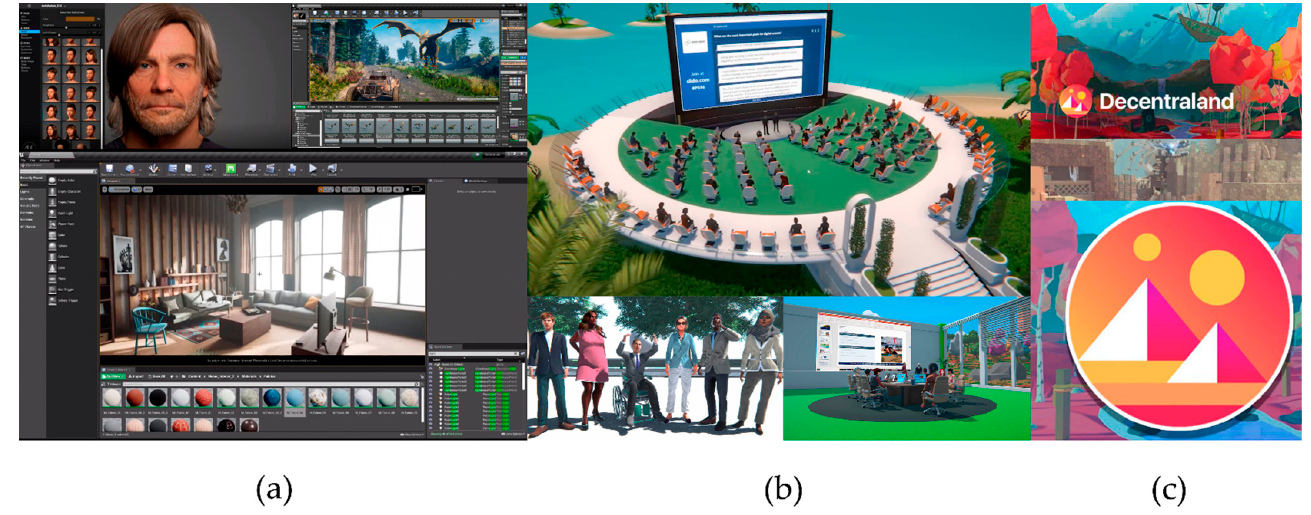
Figure 10. ( a ) On the left are screenshots of Unreal Engine: infoarchitecture and character modeling. ( b ) Breakroom metaverse meeting environments, designed for virtual collaboration: from immersive experiences to virtual events, virtual classrooms or digital workspaces. ( c ) On the other hand, we have other experiences, such as Decentraland, in which concepts such as cryptocurrencies, represented here as mana, already appear.